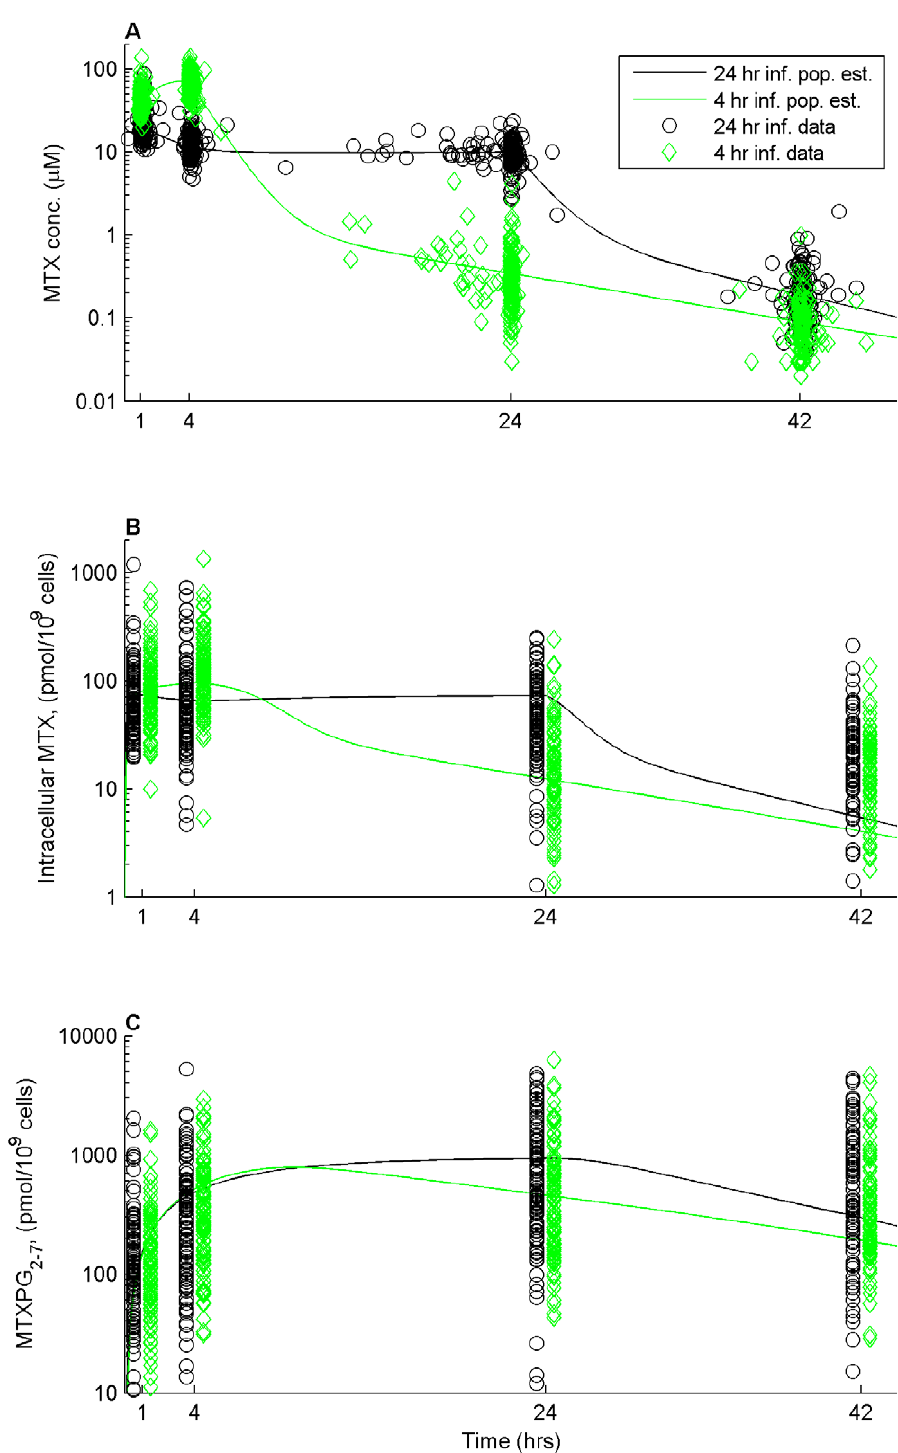
Figure 1. MTX and MTXPG concentration vs time plots. ( A ) Plasma MTX concentration ( m M) vs time (hrs). ( B ) Intracellular MTX (MTXPG 1 ) concentration in peripheral blood cells (pmol/10 9 cells) vs time (hrs). ( C ) Intracellular MTXPG 2-7 concentration in peripheral blood cells (pmol/10 9 cells) vs time (hrs). Black lines and circles represent the model fit and data given a 24 hour infusion and green lines and dimonds represent the model fit and data given a 4 hour infusion. We plotted the MTXPG concentrations at fixed time points around each sampling time to prevent the samples from the two different infusion groups from overlapping.